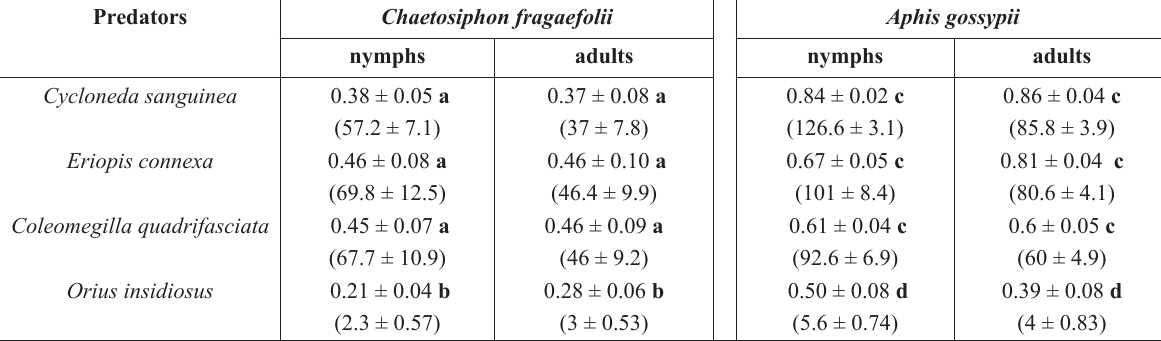
Predation rate and number of aphids consumed (in parentheses) in 24h by different predator species. The data correspond to the means ± the standard error.